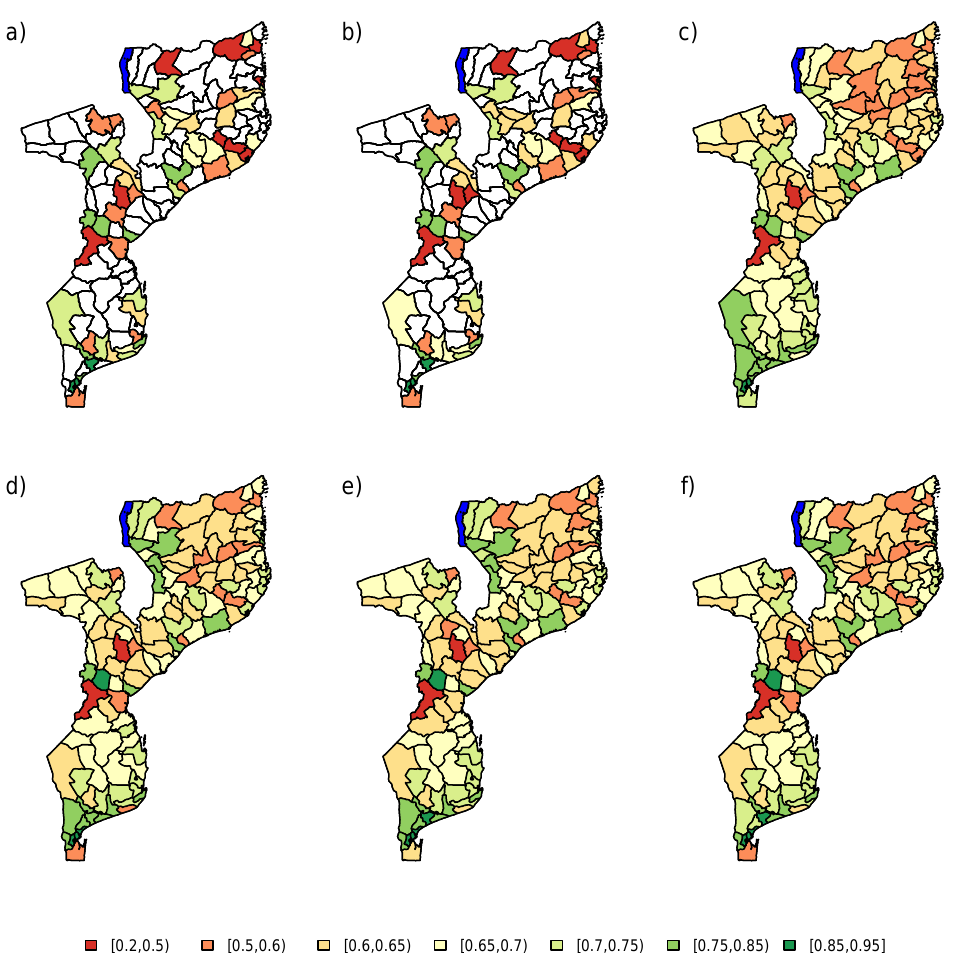
Figure 10. Maps for estimated school attendance proportions in 2008 PSIA study for ( a ) UNW, ( b ) HT, ( c ) NB, ( d ) LN, ( e ) AS, and ( f ) ES estimators. The information from variable “energy” was used as auxiliary data. UNW = unweighted estimator; HT = Horvitz–Thompson estimator; NB = naive binomial model; LN = logit-normal model; AS = arcsine model; ES = effective sample size